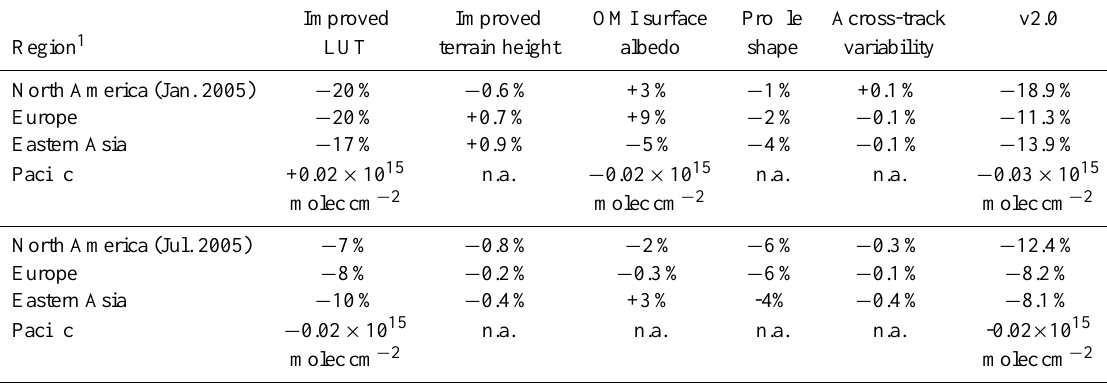
Table 2. Summary of individual changes in regional tropospheric NO 2 retrievals relative to DOMINO v1.02. v2.0 refers to the combined effect of all individual changes.